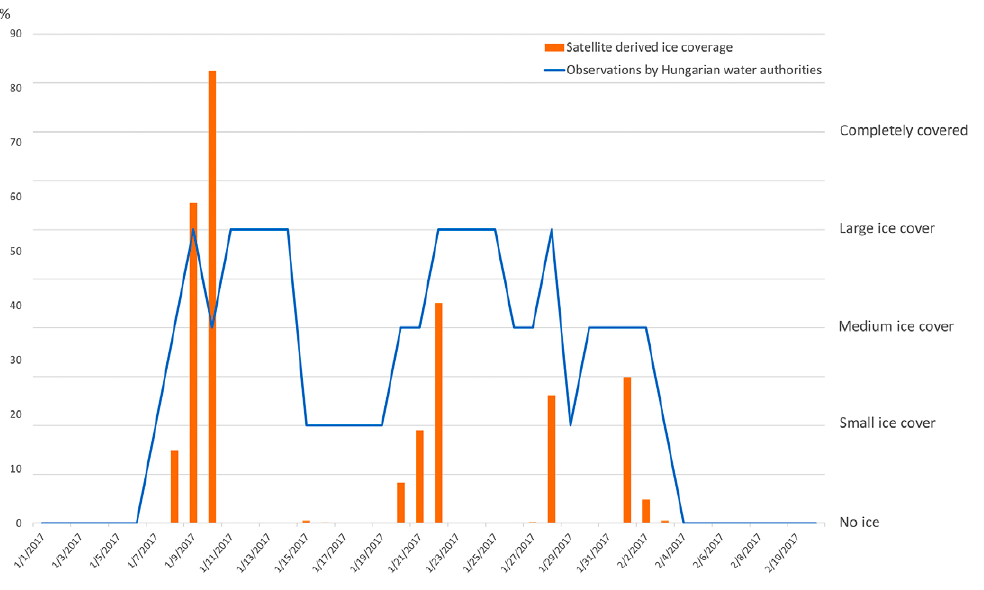
Figure 8. Comparison of satellite derived ice coverage in percentage and in situ observation by the Hungarian General Directorate of Water Management (https://www.hydroinfo.hu) for a section of the Danube between the cities of Dunaföldvár and Bölcske in 2017. Only dates when the satellite image was available are shown on the x -axis